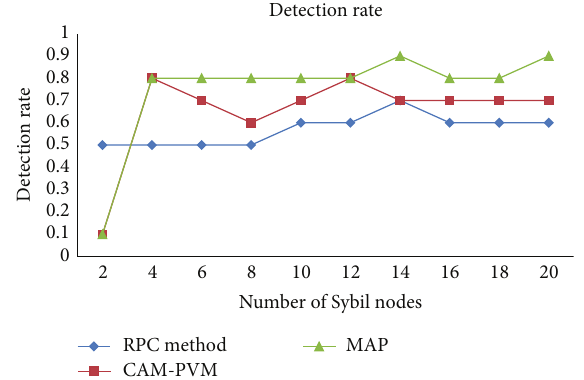
Figure 6: Comparison of detection rate with existing RPC method with proposed CAM-PVM and